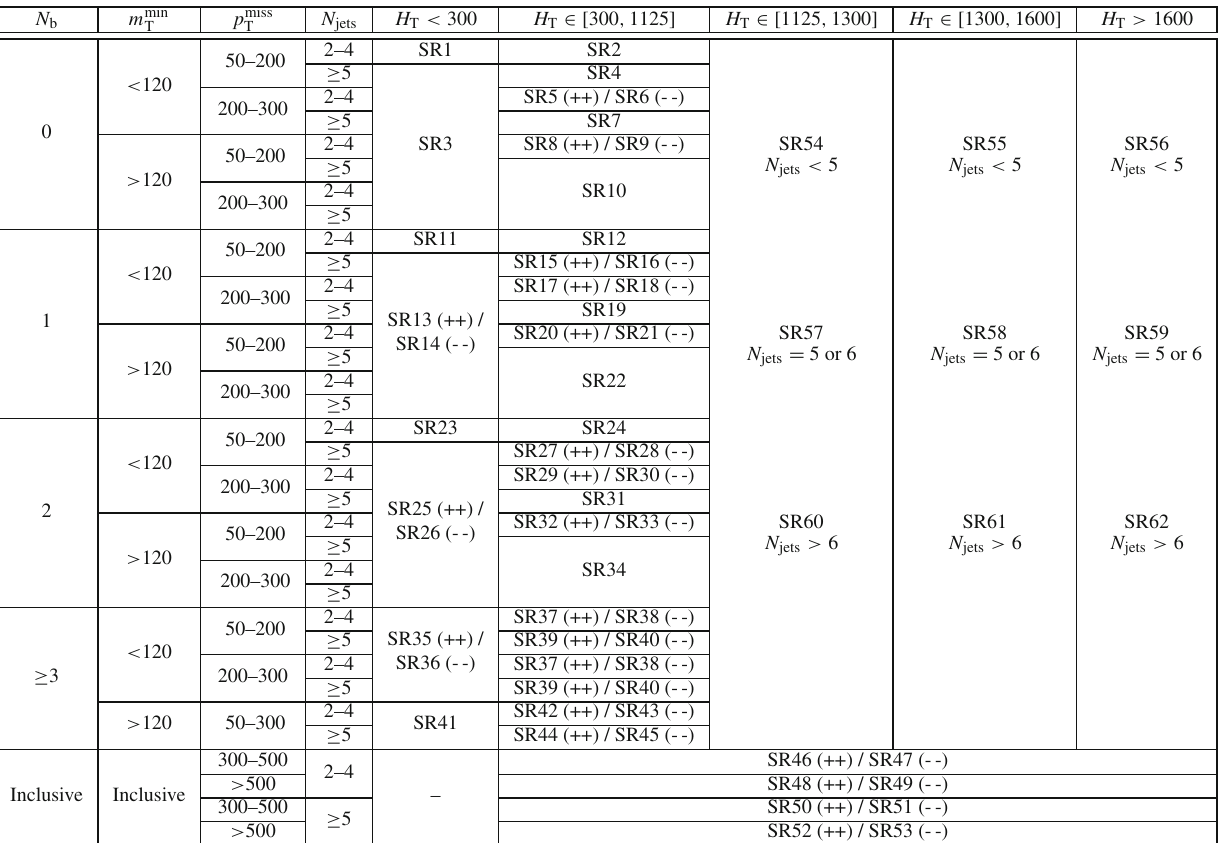
Table 2 The SR definitions for the HH category. Charge-split regions are indicated with (++) and (--). The three highest H T regions are split only by N jets , resulting in 62 regions in total. Quantities are specified in units of GeV where applicable.